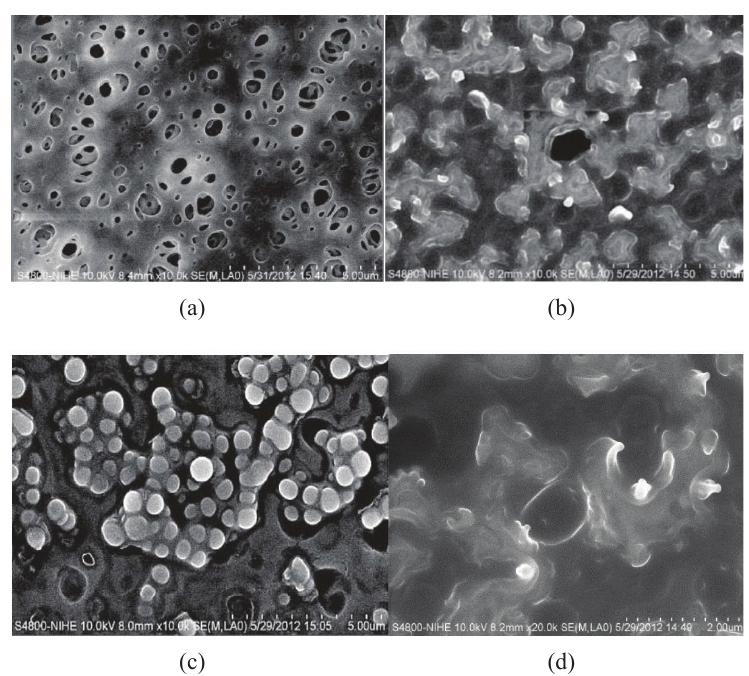
Fig. 3 – Surface of PES membranes before and after impregnation with differ­ ent ILs (a: original, b: after impregnation with [OMIM][CH pregnation with [BMIM][CH